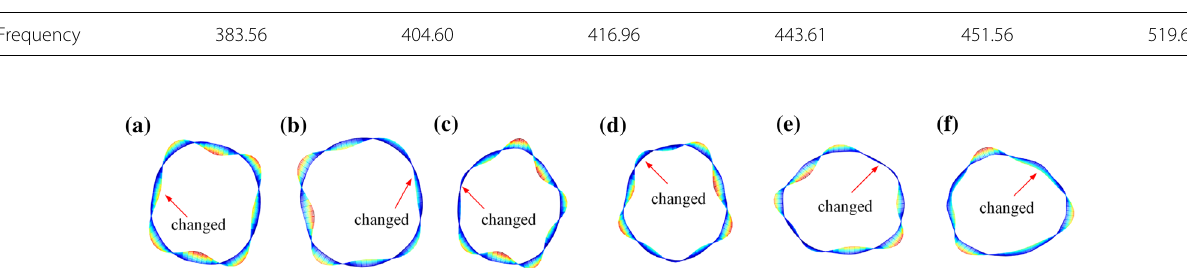
Figure 6 Mode shapes of cylindrical shell for a random mistuned bolt distribution sample with σ θ the third order; d the fourth order; e the fifth order; f the sixth